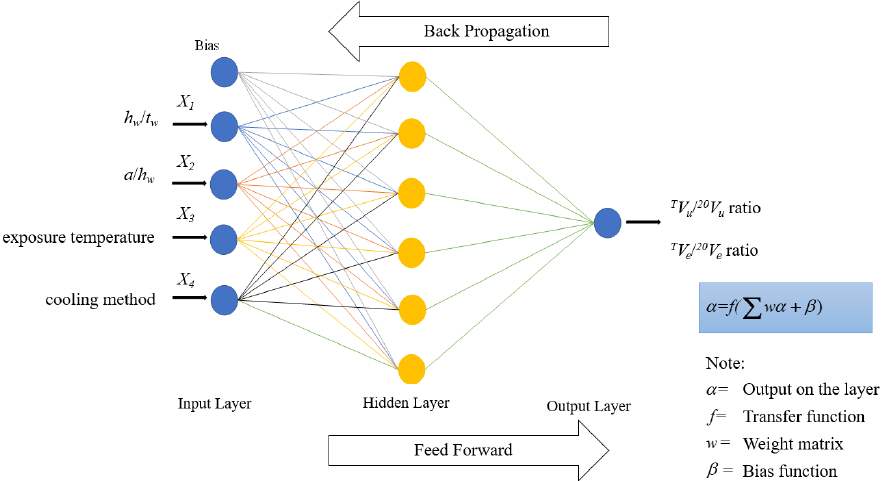
Figure 11. Technological structure of ANN_BP.